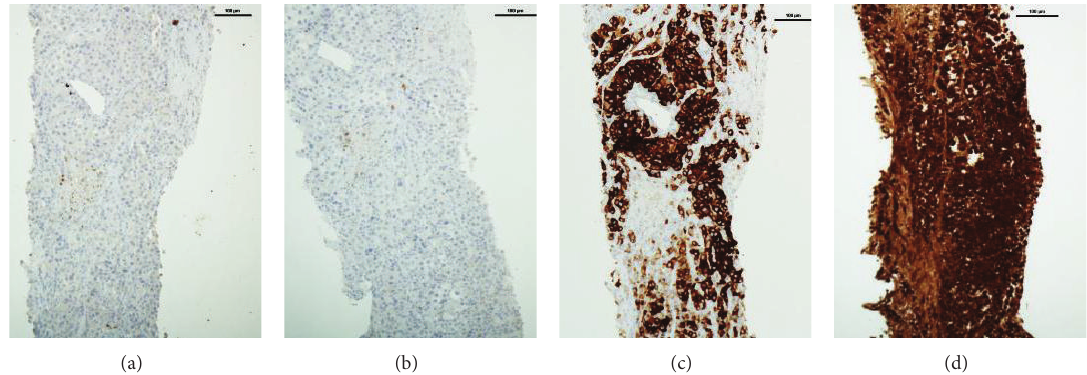
Figure 2: Histological analysis of lung biopsy. Tissue was negative for primary lung cancer ((a) CK stain and (b) TTF-1 stain) and was positive for melanoma ((c) Melan A stain and (d) S100